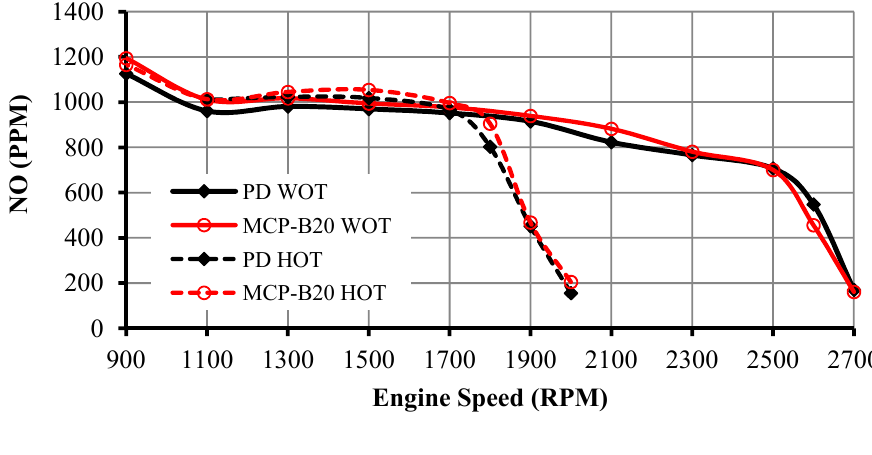
Figure 14. The relationship between tractor engine speeds (RPM) and NO (PPM) for PD and